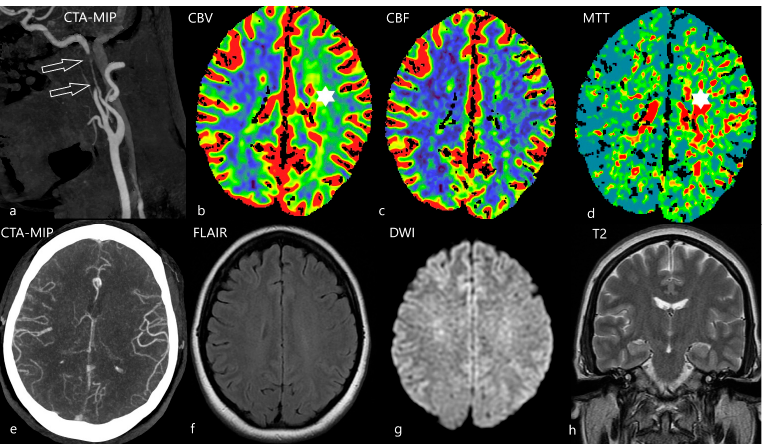
Figure 5. The effect of symmetric collaterals. 40-year-old female referred to emergency for unclear weakness of the right sided limbs and very discrete expressive aphasia that was mentioned by the patient herself since the previous evening. On the CT angiography (CTA) with maximum intensity projection (MIP), stenosis of the left internal carotid artery was found (arrows); dissection was suspected ( a ). CTP revealed apparent discrete signs of hyperperfusion on cerebral blood volume [CBV, ( b ), star], no abnormalities were apparent on cerebral blood flow [CBF, ( c )], mean transit time (MTT) was slightly prolonged [( d ), star]. Collaterals on CTA with MIP reconstruction were symmetric ( e ), on MRI scan ( f – h ) there were no signs of acute ischemia. She was treated by wall-stent insertion and the next day she was released on home care without any neurology symptoms. The source of dissection was not revealed.